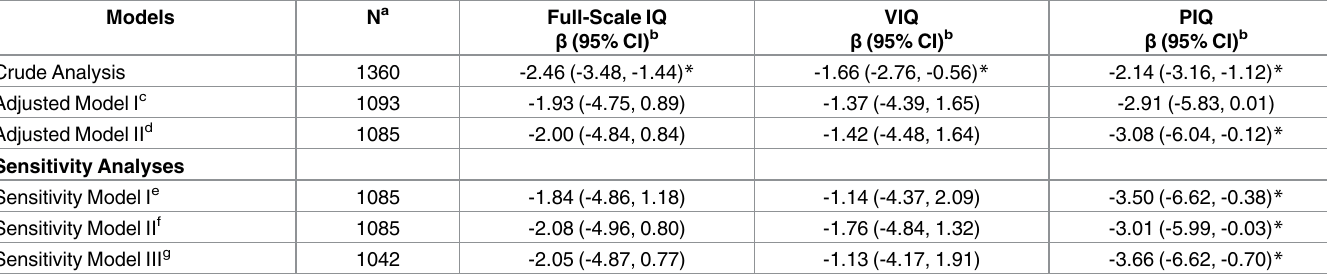
Table 3. Associations between PM 2.5 and IQ